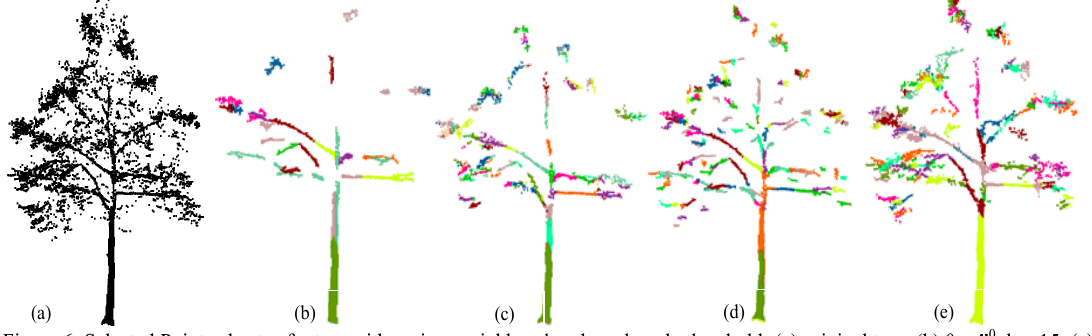
Figure 6. Selected Point subsets of a tree with various neighbourhoods and angle threshold; (a) original tree, (b) θ = 7 0 , kn=15, (c) θ =7 0 , kn=50, (d) θ =15 0 , kn=15 and (d) θ =15 0 ,